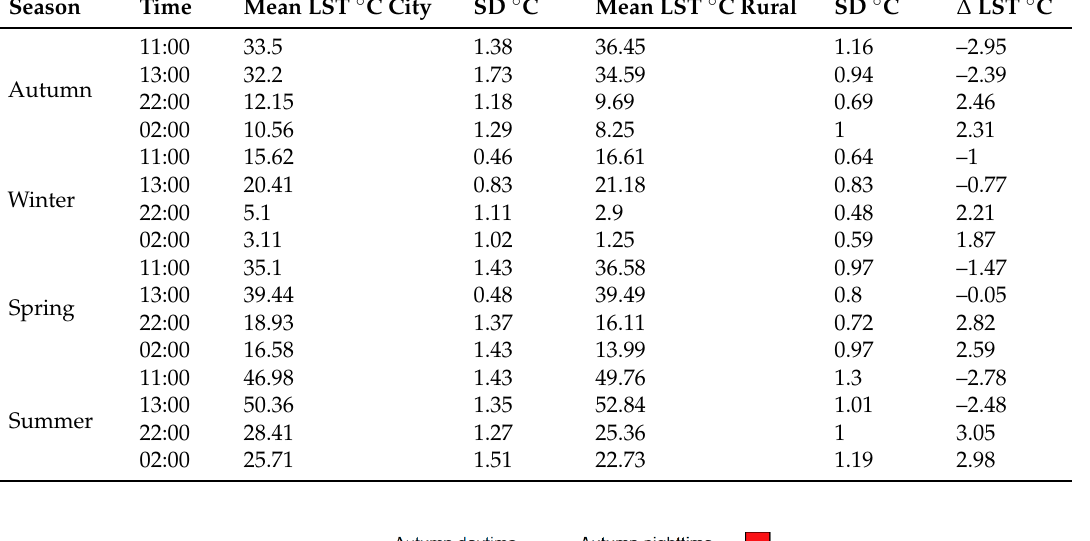
Table 3. Diurnal variation of average Land Surface Temperature and ∆ LST in different seasons over 12 years from Aqua and Terra MODIS.